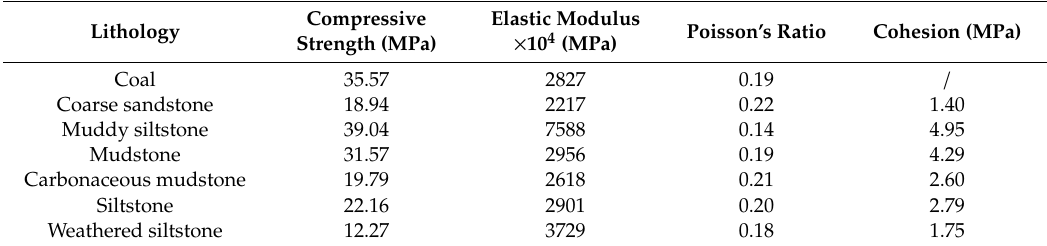
Table 2. The parameters of coal and roof of no. 22201 working